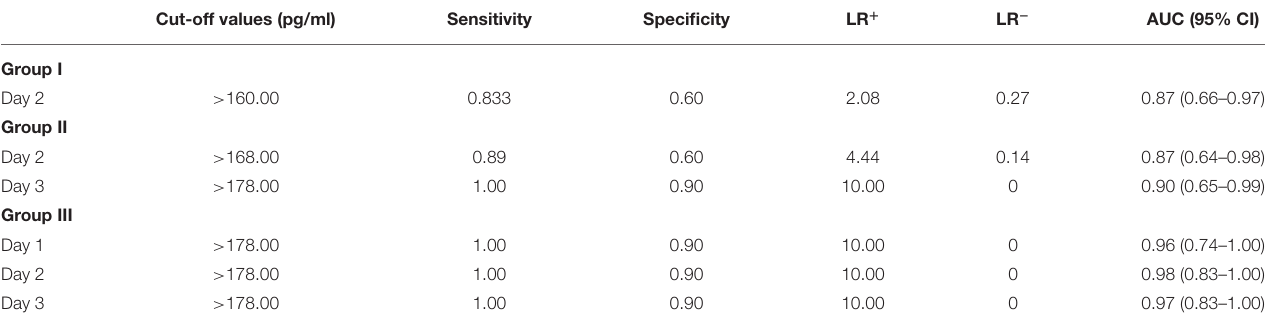
TABLE 4 | Sensitivity, specificity, LR + , and LR − at the best cut-off values of sCD40L in distinguishing simple appendicitis, gangrenous appendicitis and ruptured appendicitis from normal appendices in children. Cut-off values